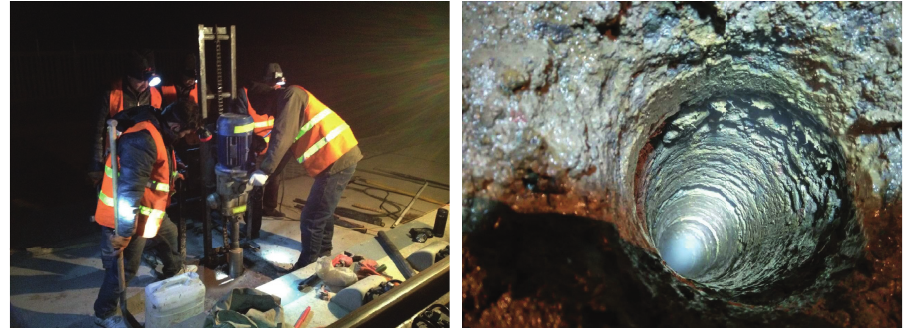
Figure 1: Fieldwork of the automatic monitoring system of moisture content of subgrade materials of high-speed railway in cold